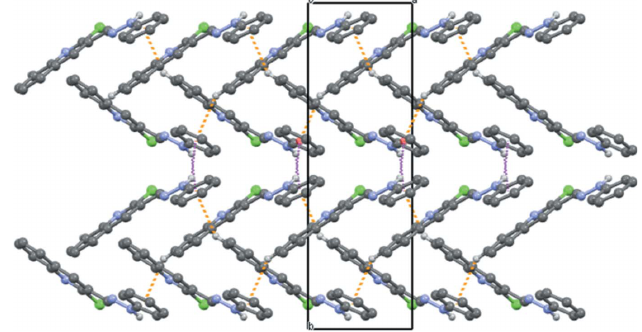
Figure 4 Aview along the c axis of the crystal packing of compound 5 . H atoms not involved in the C—H (cid:2)(cid:2)(cid:2) (cid:2) and N—H (cid:2)(cid:2)(cid:2) (cid:2) interactions (dotted orange and purple dashed lines, respectively) have been omitted for